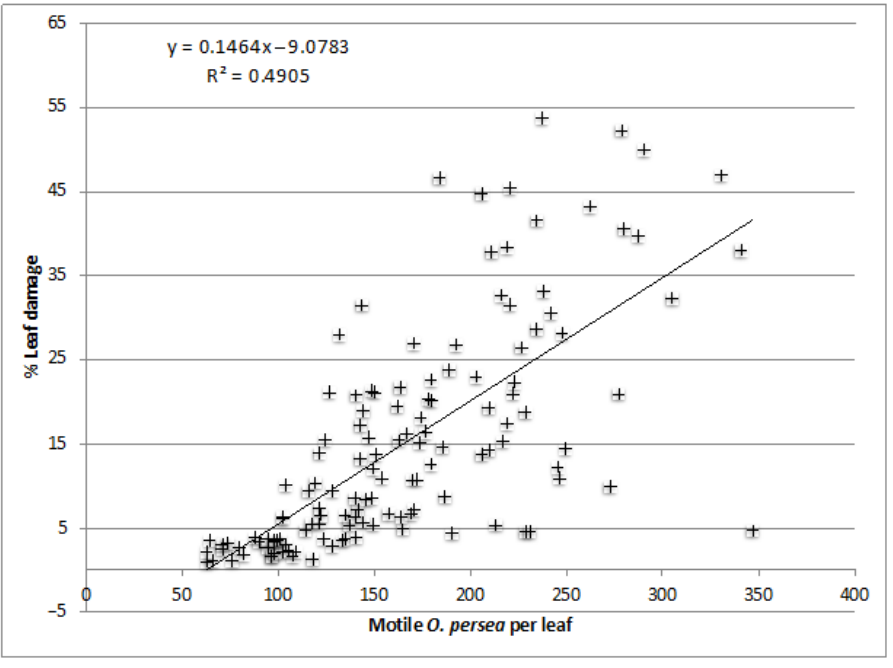
Figure 3. Linear regression for seasonal (2011–2013) percentage leaf area damage (PLAD) as a function of seasonal cumulative mite days (CMDs) of O. perseae per leaf.